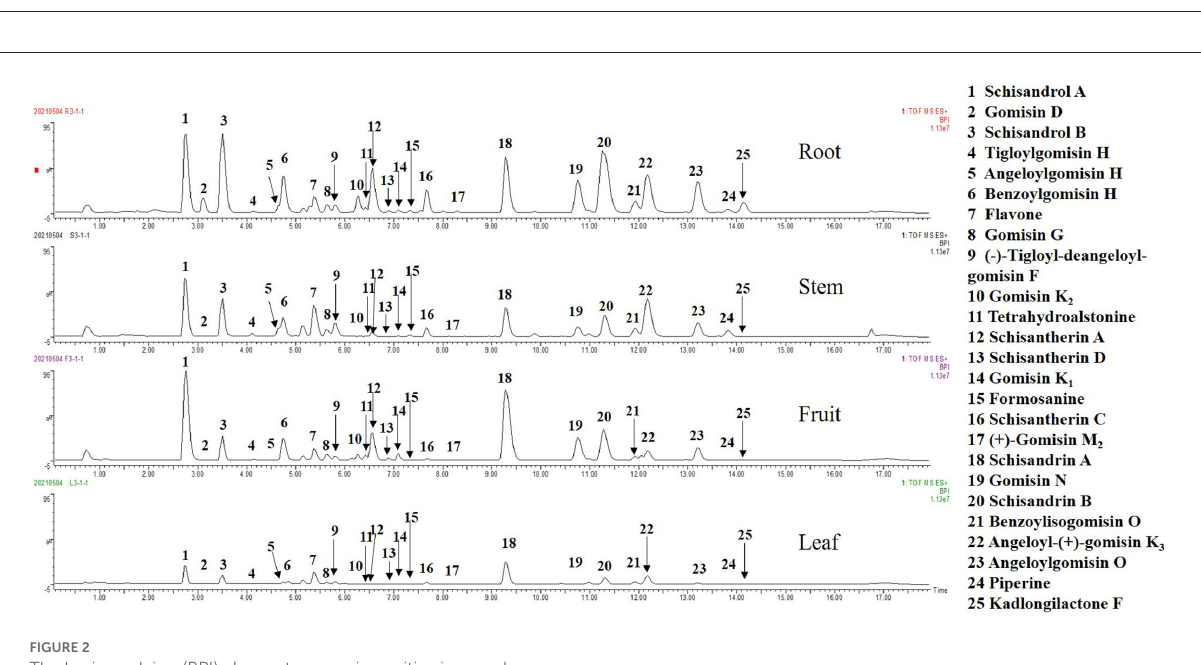
FIGURE2 The basic peak ion (BPI) chromatograms in positive ion mode.